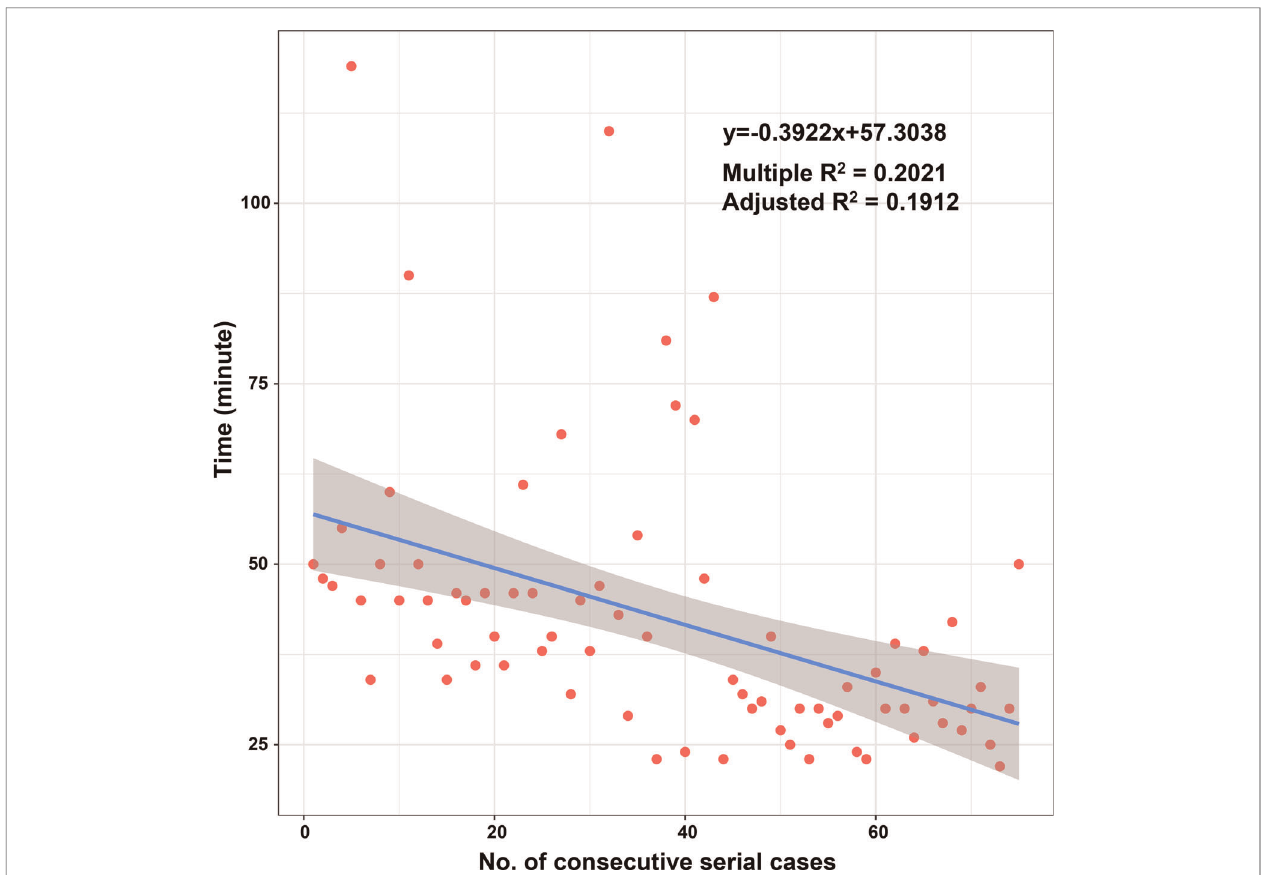
FIGURE 1 | Scatter plot of operative time and progressive case